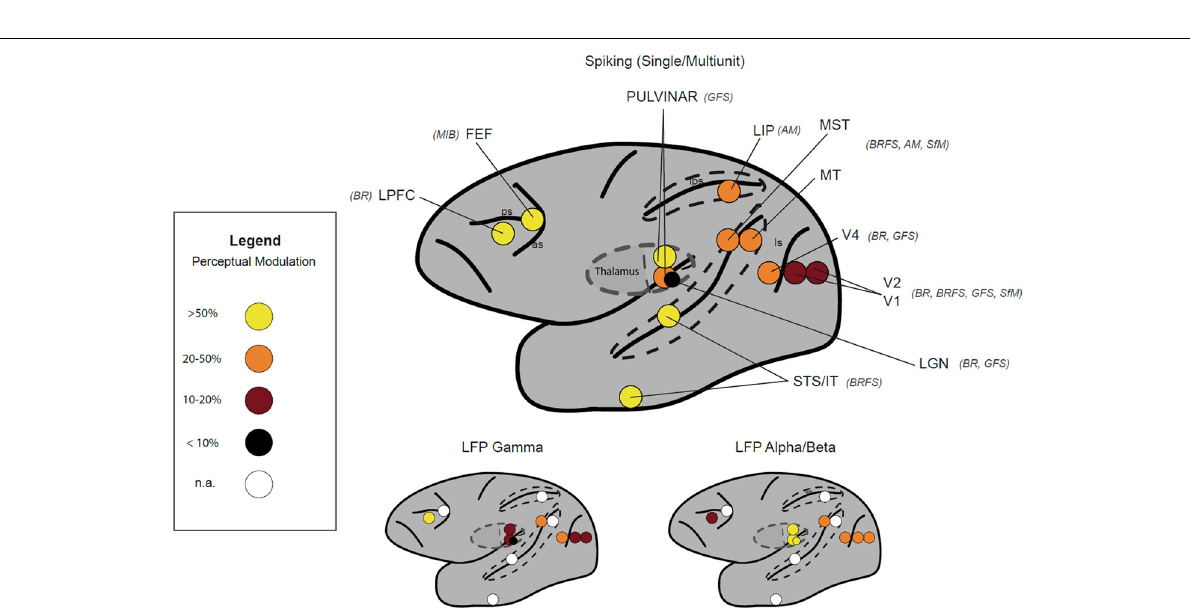
et al., 2004; Wilke et al., 2006; Maier et al., 2008; Keliris et al., 2010), LGN (Lehky and Maunsell, 1996; Wilke et al., 2009), STS/IT (Sheinberg and Logothetis, 1997; Kreiman et al., 2002), MT/MST (Logothetis and Schall, 1989; Williams et al., 2003; Maier et al., 2007; Wang et al., 2009), LIP (Williams et al., 2003), pulvinar(Wilkeet al.,2009), FEF(Libedinsky andLivingstone, 2011), and LPFC (Panagiotaropoulos et al., 2012). Abbreviations: BR, Binocular Rivalry; BRFS, Binocular Rivalry Flash Suppression; GFS, Generalized Flash Suppression; SfM, Structure-from-Motion; AM, Apparent Motion